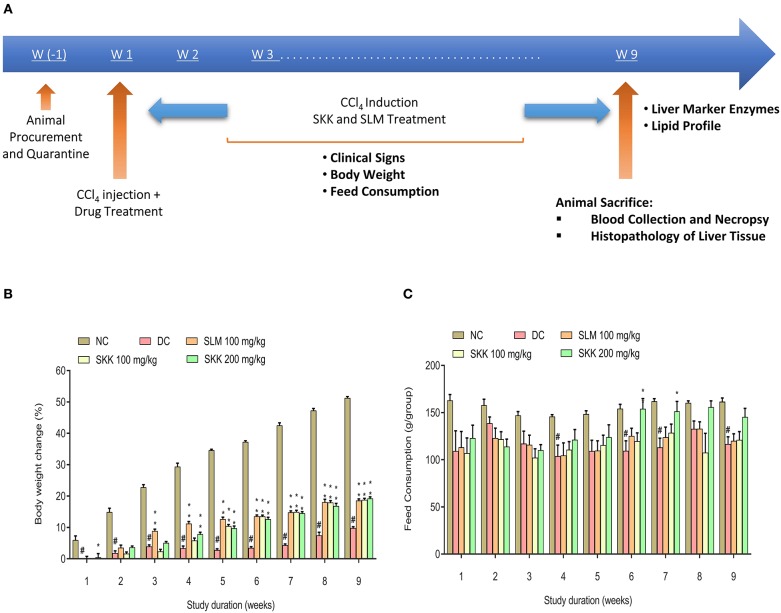
In-vivo pharmacological effect study of Divya Sarva-Kalp-Kwath (SKK) in carbon tetrachloride (CCl4) treated wistar Rats: (A) Wistar rats were divided randomly into four groups (n = 5): Group 1 (NC): Animals were administered with olive oil (intraperitoneal injection; 0.25 ml/kg; every 3rd day for 9 weeks) and 0.25% Na-CMC, Group 2 (DC): Animals were administered with CCl4 in olive oil v/v (intraperitoneal injection; 0.5 ml/kg; every 3rd day for 9 weeks), Group 3 (PC): Animals were administered with CCl4 in olive oil v/v (intraperitoneal injection; 0.5 ml/kg; every 3rd day for 9 weeks) with the concurrent oral treatment of SLM (100 mg/kg; once daily for 9 weeks), Group 4 (SKK-treated): Animals were administered with CCl4 in olive oil v/v (intraperitoneal injection; 0.5 ml/kg; every 3rd day for 9 weeks) with the concurrent oral treatment of SKK (100 and 200 mg/kg; once daily for 9 weeks). The animals were observed for physiological, histopathological, and biochemical changes during and after completion of the study period. (B) Substantial loss of body weight was detected in the CCl4 stimulated Wistar rats. Treatment of the CCl4 stimulated animals with human equivalent and higher dose of SKK (100 and 200 mg/kg) resulted in the minor recovery in body weight loss. (C) Wistar rats treated with CCl4 showed loss of food habits over a period of 28 days. Recovery was detected in the CCl4 stimulated animals following treatment with the high dose of SKK (200 mg/kg). SLM (100 mg/kg) was used as a positive control in the study and did not induce any changes in the feed habits. Results are expressed as Mean ± Standard Error of Means. One-way analysis of variance (ANOVA) followed by Dunnett's multiple comparison t-test was used to calculate the statistical difference. p-value #<0.01; *<0.05; **<0.01.